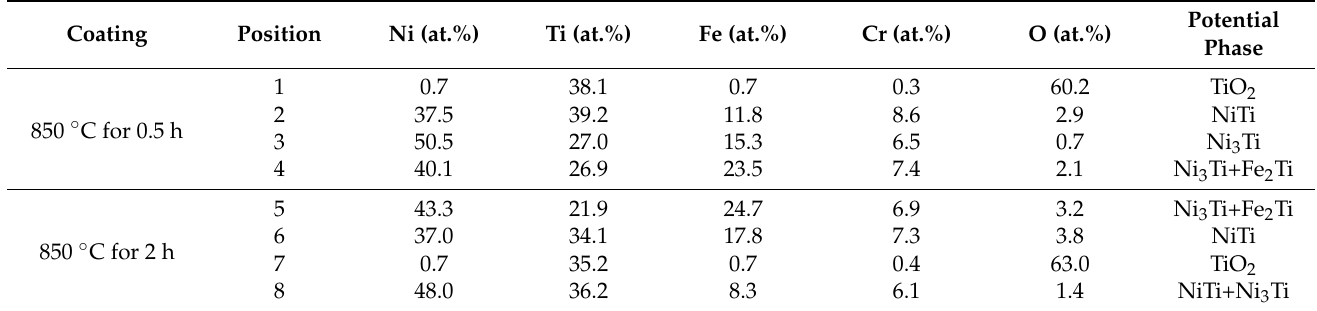
Table 5. EDS scanning results of the positions marked in Figure